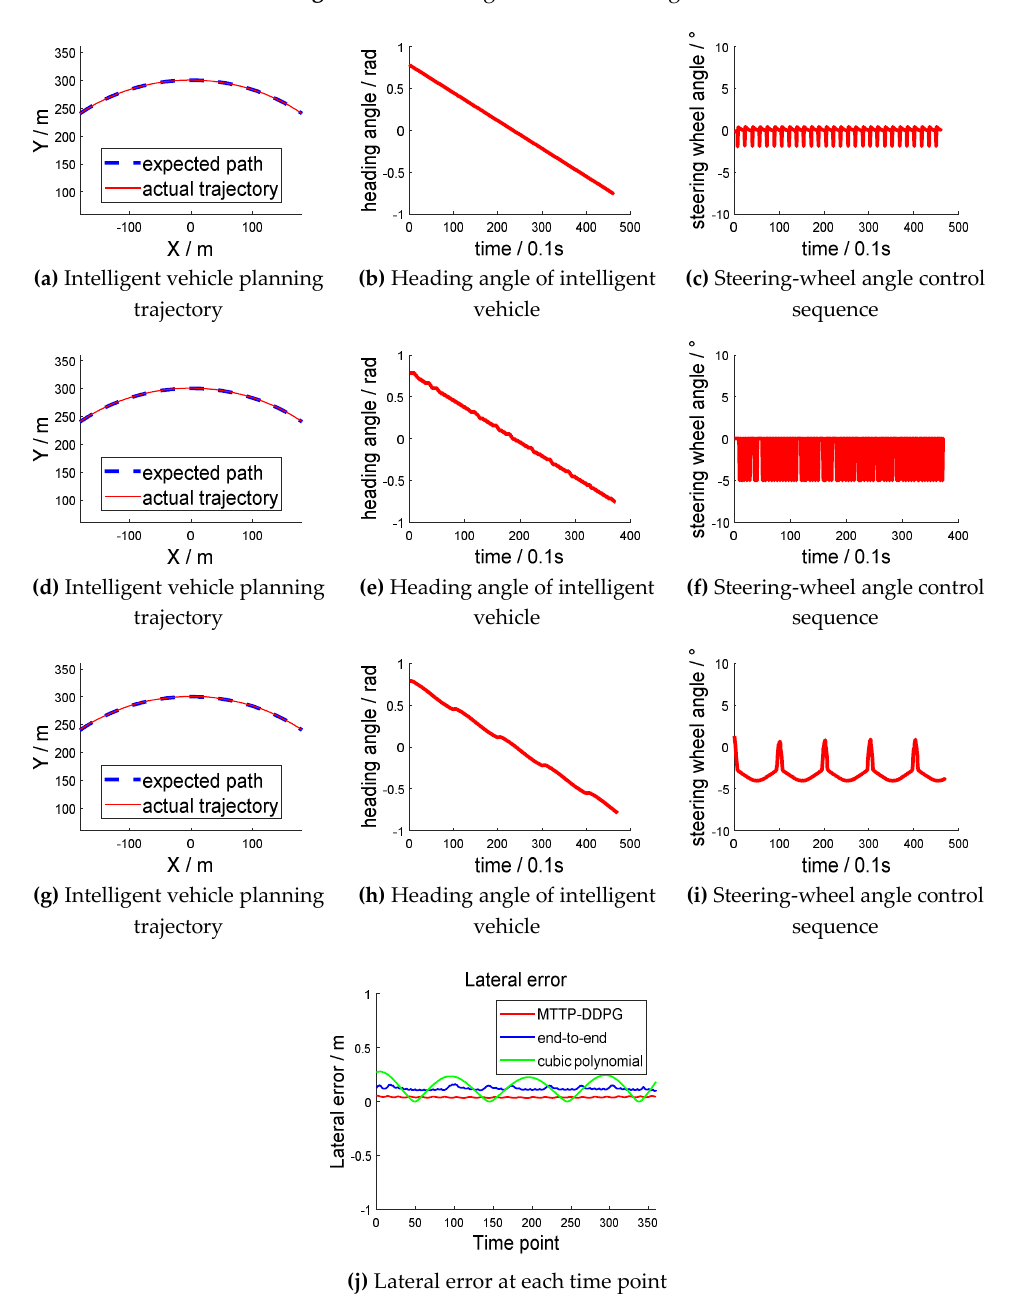
Figure 11. Contrast experiment of arc straight track scene.